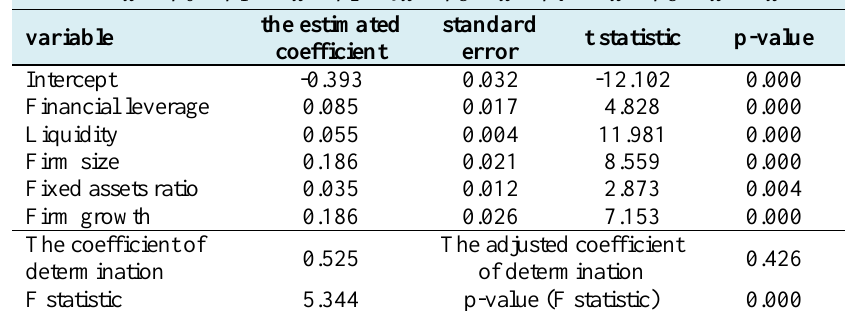
Table 20. The results of estimating the first model of research in the TSE (without considering the effects of the